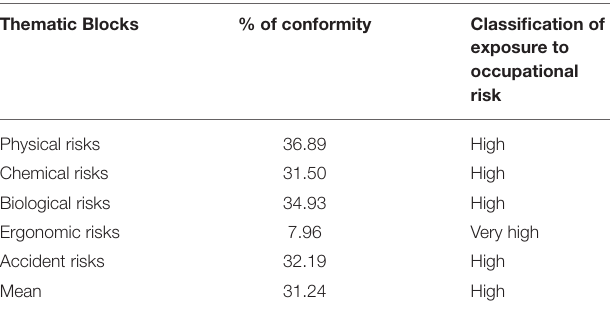
TABLE 1 | Thematic Blocks, percentage and classification of Exposure to Occupational Risk in school food